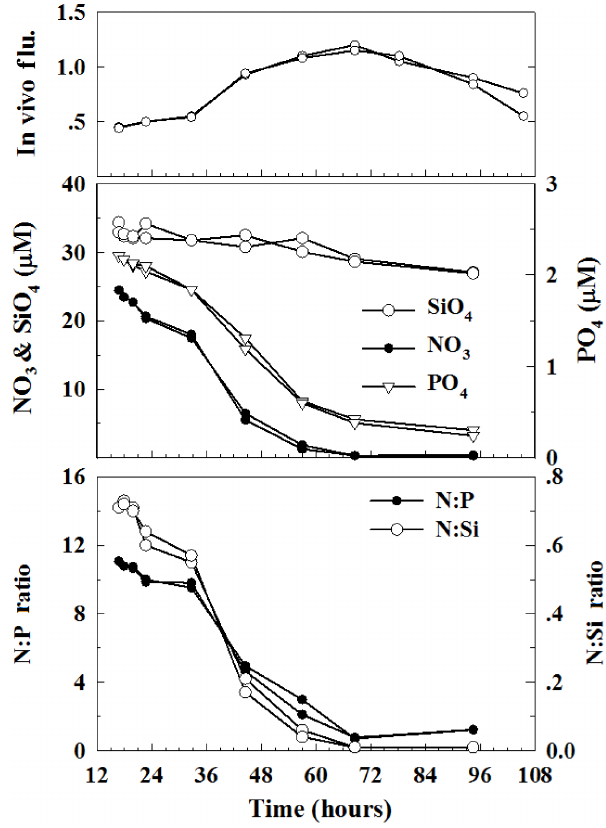
Figure 7. Time course of duplicate in vivo fluorescence, NO − PO 3 − and SiO − , and N:P and N:Si ratios during an in situ in- 4 4 cubation of a water sample taken from 1m at P3 on 11 August 1991 (11:45UTC). NO − , PO 3 − and SiO − were added to the water sam- 3 4 4 ple at T = 0 before the and N:Si 4